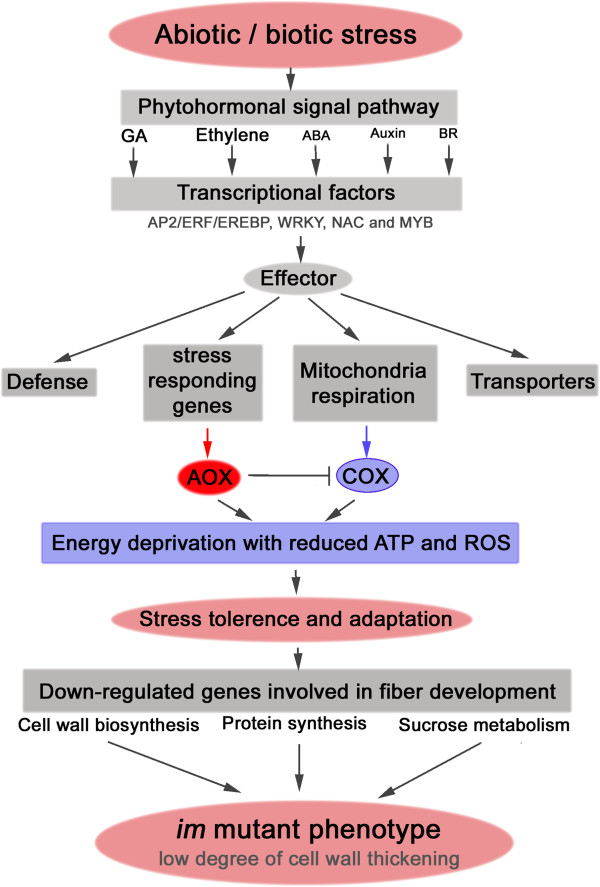
Model for reducing the degree of fiber cell wall development in the 
im 
mutant.